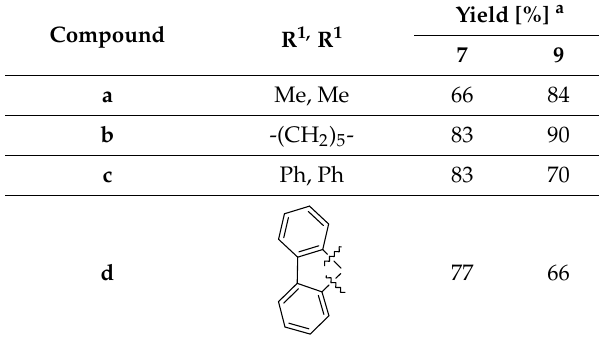
a Yield of pure, isolated products based on 5 or 7 ,